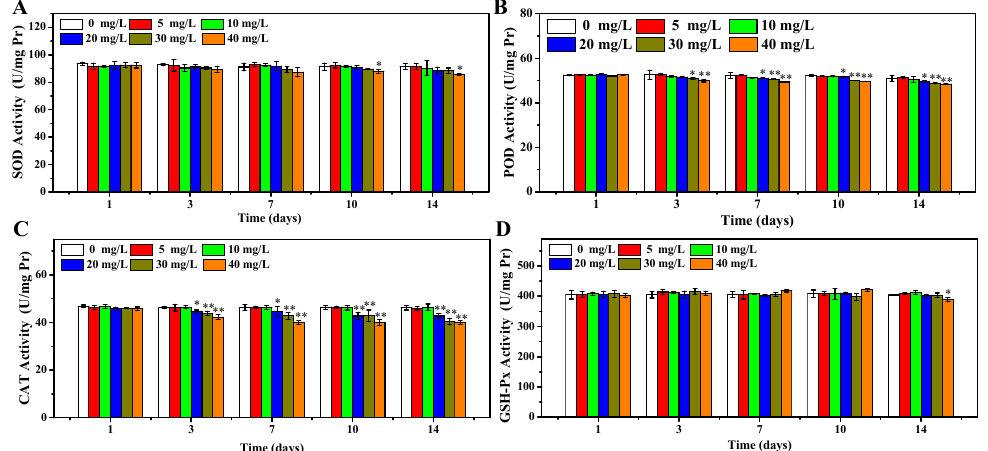
Figure 6. ( A ) SOD concentration of zebrafish, ( B ) POD concentration of zebrafish, ( C ) CAT concentra- tion of zebrafish, ( D ) GSH-Px concentration of zebrafish after exposure to OCNPs in subacute toxicity test. *, ** indicate significant differences ( p < 0.05) and remarkably significant differences ( p < 0.01).